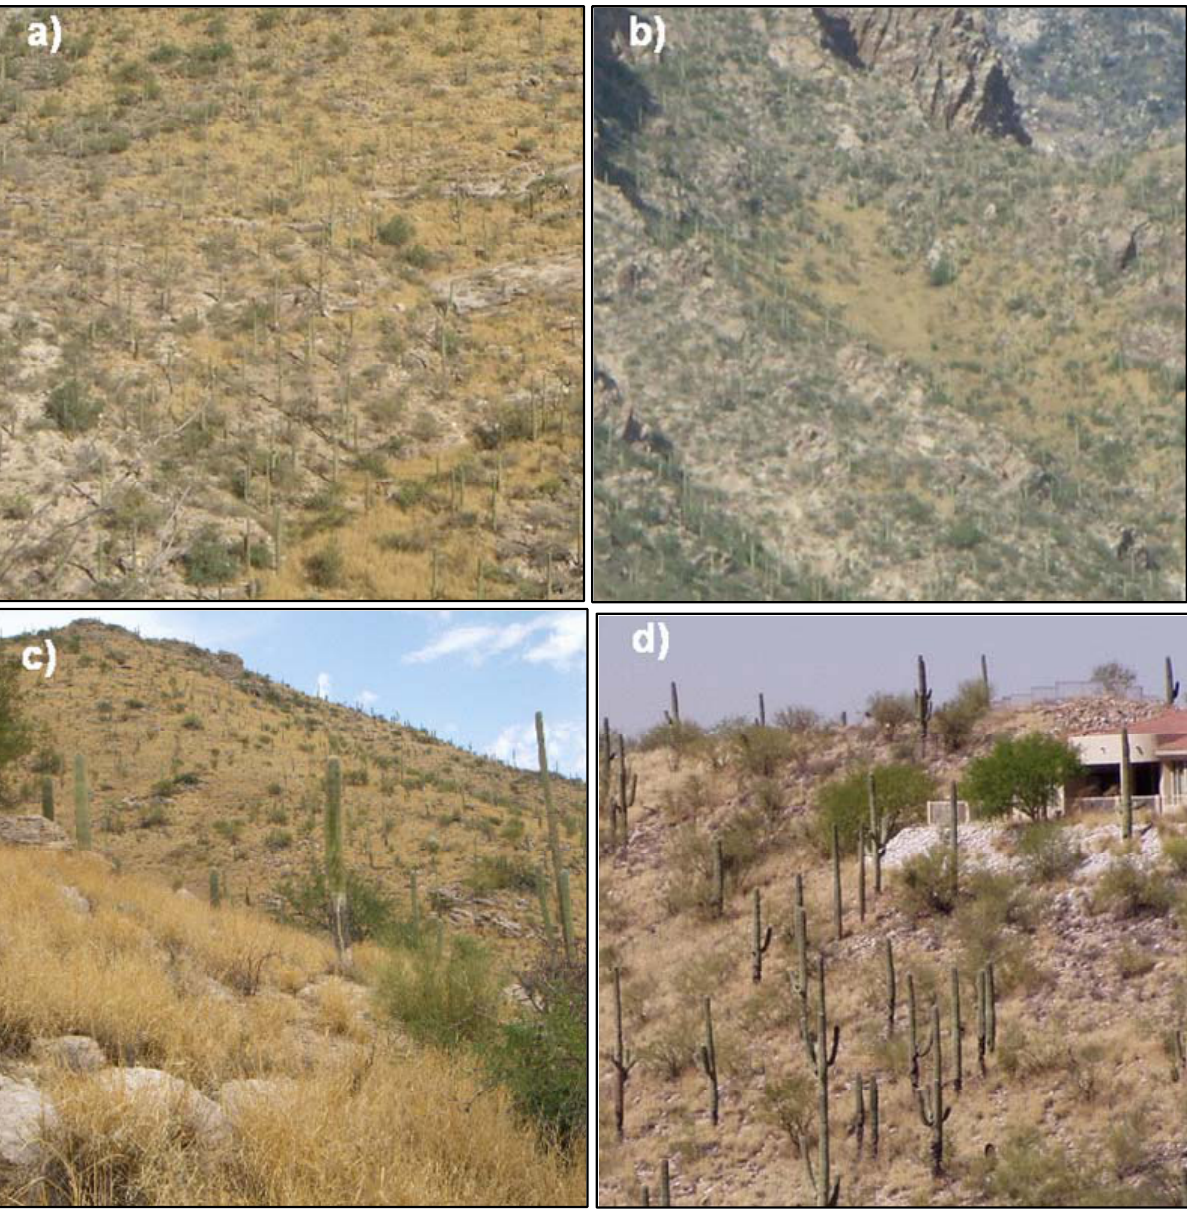
Figure 1. Photos of four P. ciliare -infested hot spots identified in the Santa Catalina Mountains. P. ciliare stands out in these images by its golden hue and smooth texture, which contrasts from the beige tones and speckle associated with uninvaded areas. The golden hue is characteristic of post-monsoon curing and although the golden hue fades, standing senesced vegetation remains a fuel concern throughout the year. The homogeneous texture is characteristic of connected grass cover, whereas the heterogeneous textures of uninvaded habitat represents a mixture of exposed soil, rocks, shrubs, cacti, and